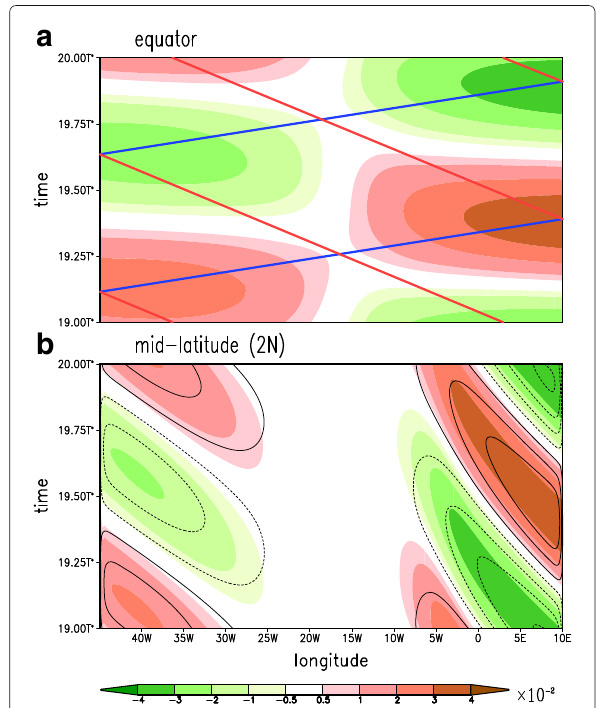
Fig. 5 a Hovmoller diagram at the equator for thickness anomaly ( colorshading , normalized) with the blue and redlines indicating the phase speeds of equatorial Kelvin waves and long Rossby waves, respectively. b Hovmoller diagram at 2 ◦ N for thickness anomaly ( color shading , normalized) and the EPV-based streamfunction ( contours , plotted as in the leftpanels of Fig. 4)